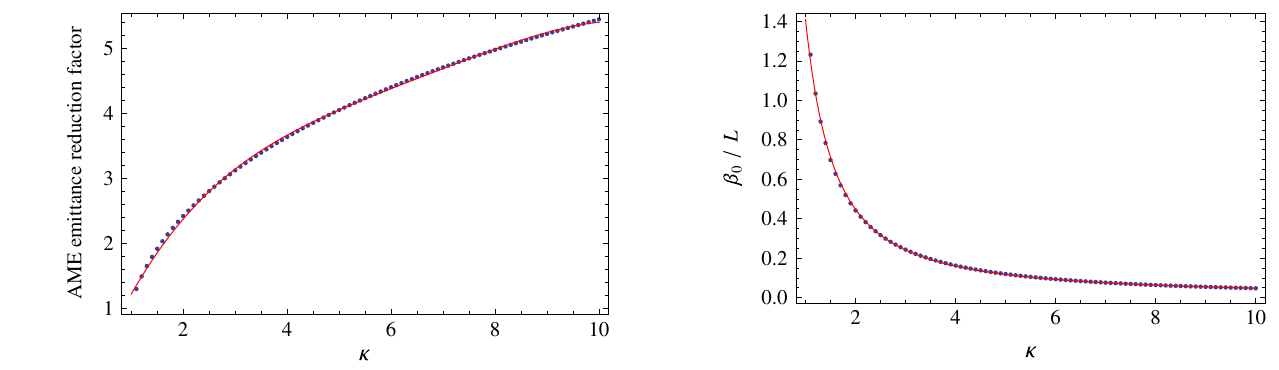
FIG. 9. The initial beta over dipole length for the minimum AME emittance. The red curve is given by the approximate ¼ 0 : 383 =(cid:12) þ 1 : 03 =(cid:12) 2 . =L expression (cid:8) 0 dipole